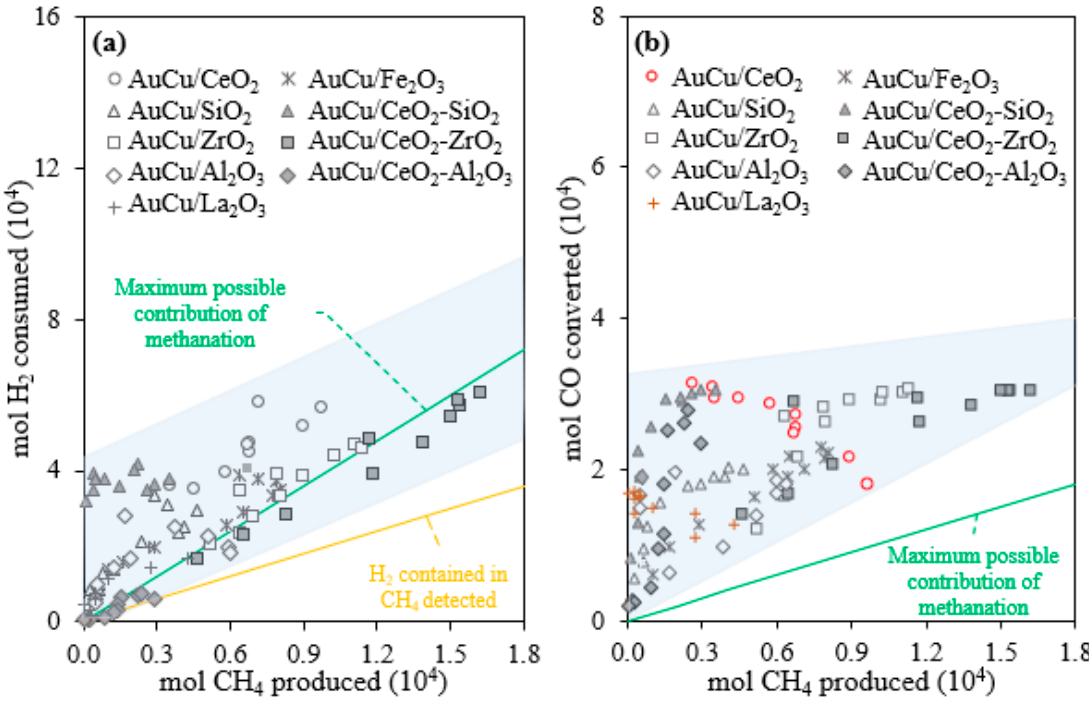
Figure 4. Contribution of methanation in ( a ) the H 2 consumption and ( b ) CO conversion during the CO removal from an actual syngas. The shaded area conveys the trend of the experimental data.